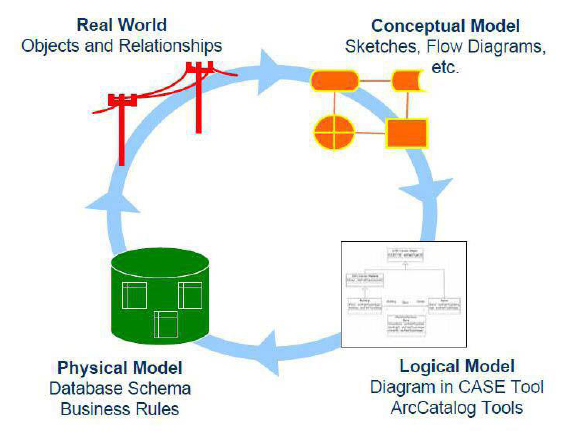
Fig. 2 – Principle of Geospatial Data Modeling